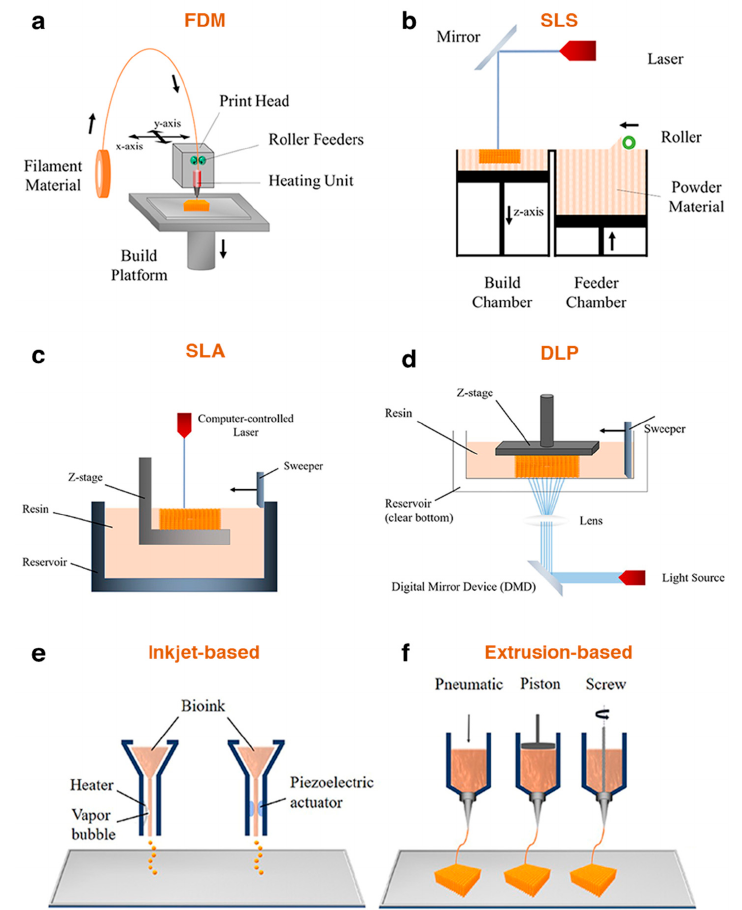
Figure 11. 3D printing principles and popular techniques. ( a ) Fused deposition modelling (FDM). A filament of thermoplastic material is continuously fed to a printer head with a heating unit, which melts the material and facilitates its extrusion and layer-by-layer deposition onto a substrate. ( b ) Selective laser sintering (SLS). The projection of a laser in a pre-defined pattern is used to sinter powdered material. Once a layer has been completed, the substrate in the build chamber lowers by a pre-determined distance, according to the computational model used, and new material is fed from the feeder chamber to start a new layer. ( c ) Stereolithography (SLA). A light source (e.g., a laser) is used to solidify liquid and photosensitive material (resin) in the desired pattern. Once a layer is completed, the substrate is lowered vertically and new resin can be polymerised on top. ( d ) Digital light processing (DLP). This is similar to SLA; it uses a digital micro-mirror device (DMD), composed of numerous micro-mirrors that direct and focus the light source to the resin surface according to the designed pattern. ( e ) Inkjet-based 3D printing. An ink or bioink is loaded into a cartridge and can be ejected with the help of heat-generated bubbles or a piezoelectric actuator. ( f ) Extrusion-based 3D printing. The (bio)ink is extruded using pneumatic or mechanic (piston/screw) systems. Adapted from [325] under the terms of the Creative Commons Attribution License (https://creativecommons.org/licenses/by/4.0/). Copyright © 2019, Tamay, et al.